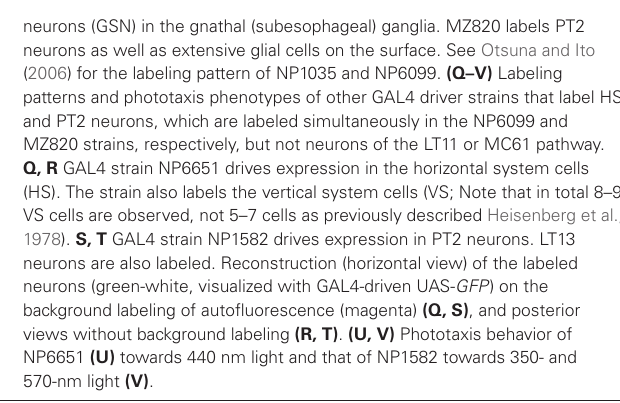
(I, J) and a sample with two FLP-induced (Wong et al., 2002) single-cell clones (K, L) are shown. In the latter, one of the cell bodies is out of the region of reconstruction (indicated with gray characters). (M, N) Distribution of presynaptic sites (white, visualized with synaptic vesicle-targeting UAS- n-Syb-GFP ) and all the neural fibers (red, with cytoplasmic UAS- DsRed ). Stacks of confocal horizontal sections. Lo3-5 and M6L, 6M and 7 indicate the layers of dendrites with (white) and without (yellow) presynaptic cites. Note that some of the cell bodies (CBs) are labeled with surplus amount of n-Syb-GFP. (O–P) Labeled cells in the central brain. In addition to the MC61 neurons, NP302 labels glial cells on the surface, dorsal giant interneuron (DGI), mushroom body neurons (MB), terminals of the olfactory sensory neurons (OSN) in the antennal lobe, and putative gustatory and other sensory